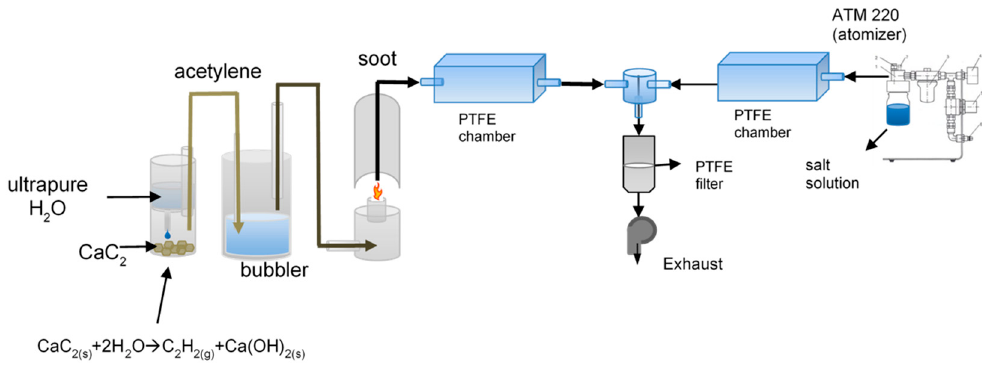
Figure 2. Outline scheme of the mixed saline and soot aerosol generation and sampling system.